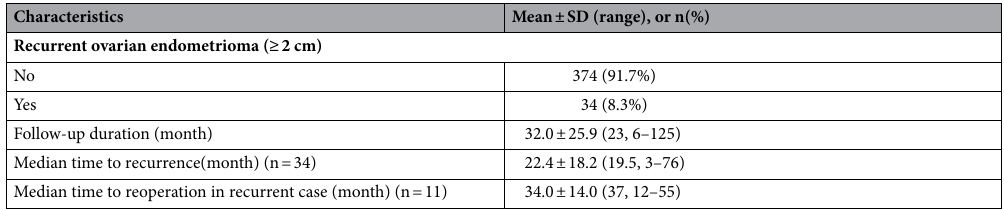
Table 1. Baseline characteristics of patients with 40–49 years (n = 408). BMI, body mass index; CA125, cancer antigen 125; AMH, anti-Mullerian hormone; rASRM, revised American Society for Reproductive Medicine; Mo, month.